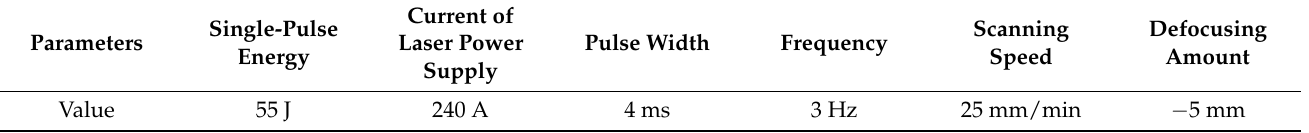
Table 1. Laser parameters and motion table parameters in pulsed laser wire-feeding